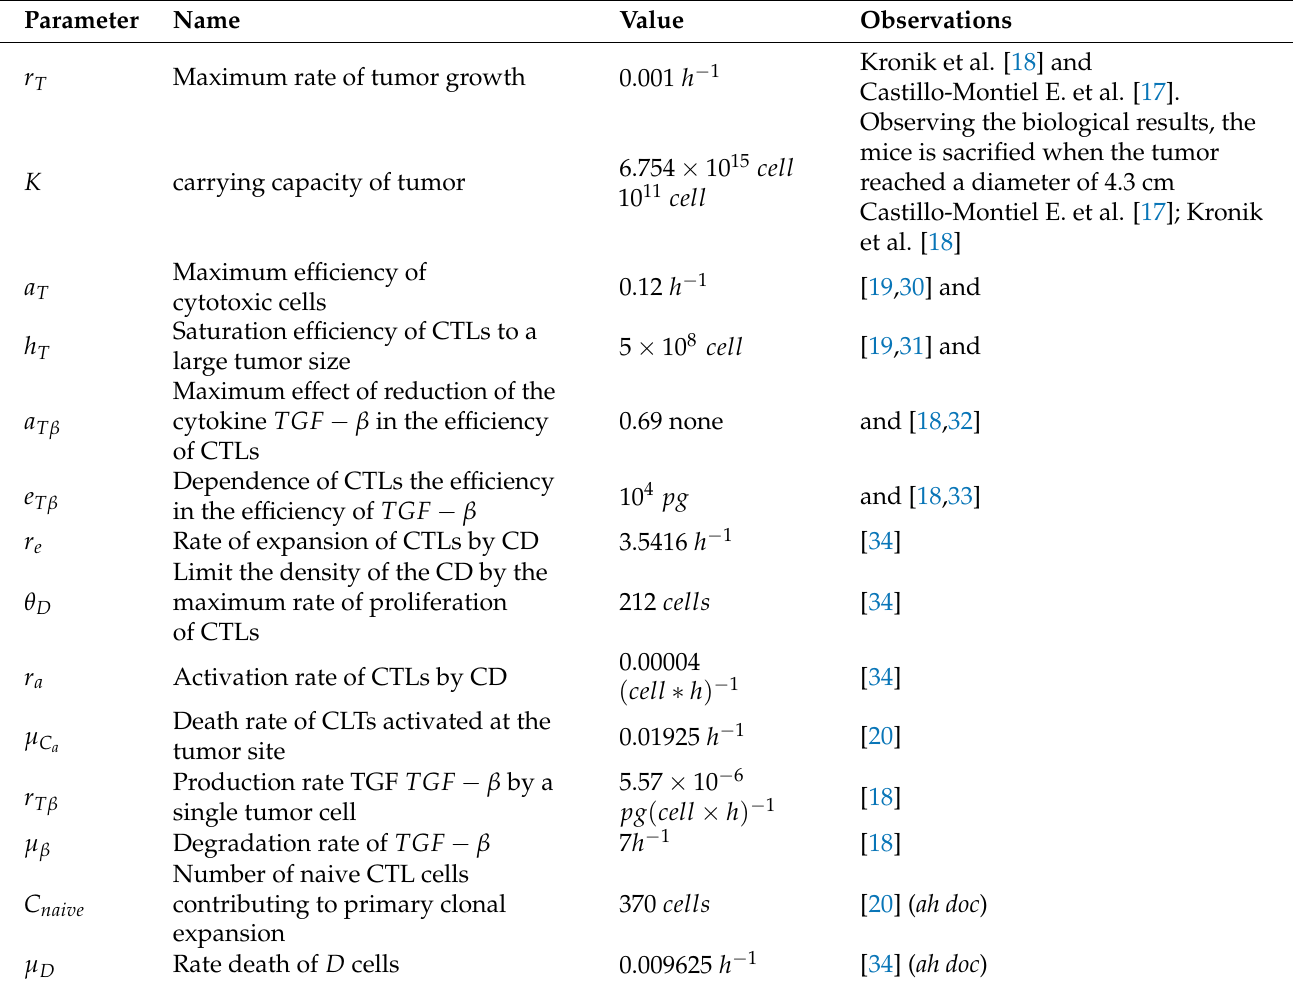
Table A2. Parameters used in the